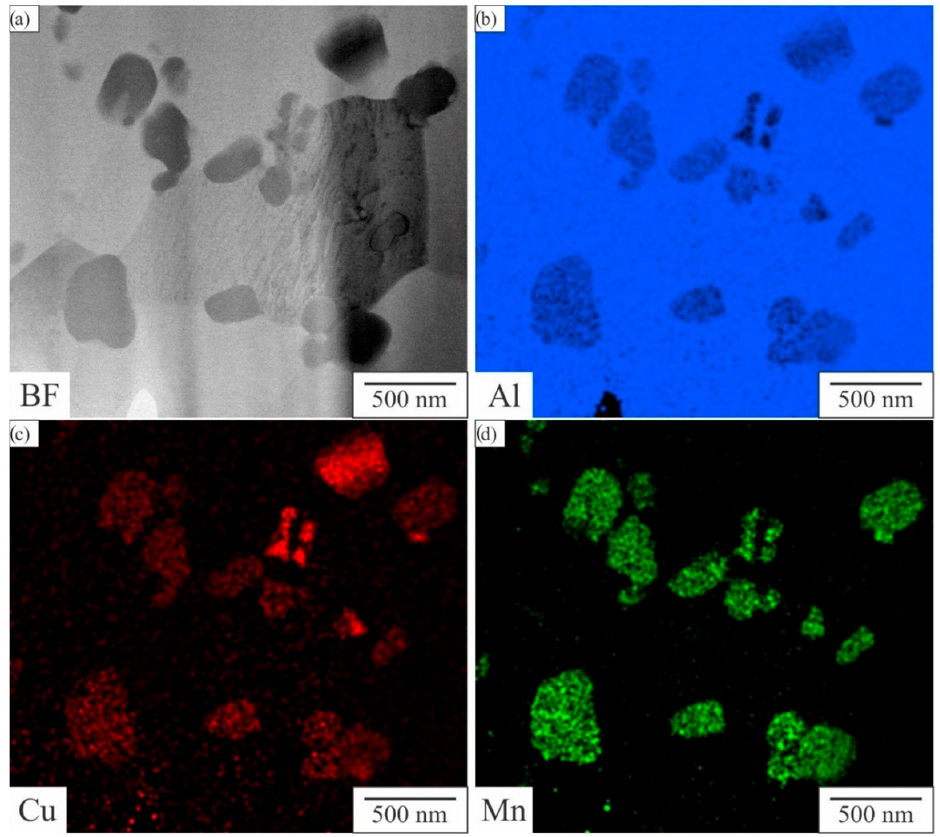
Figure 15. Microstructure in the TMAZ, close to the stir zone (within the area TR-S in Figure 2) of sample FSP950. ( a ) Bright-field STEM micrograph ( a ) and elemental distributions of ( b ) Al, ( c ) Cu, and ( d ) Mn extracted from EDS.